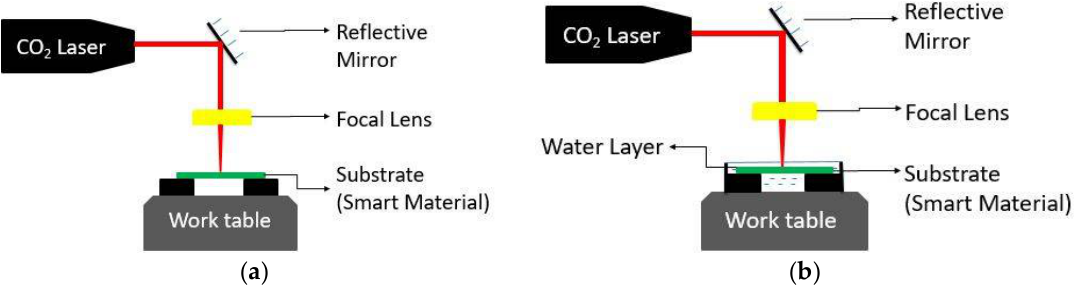
Figure 1. Schematic of Laser Beam Micromachining Process ( a ) in air ( b ) Liquid-Assisted.